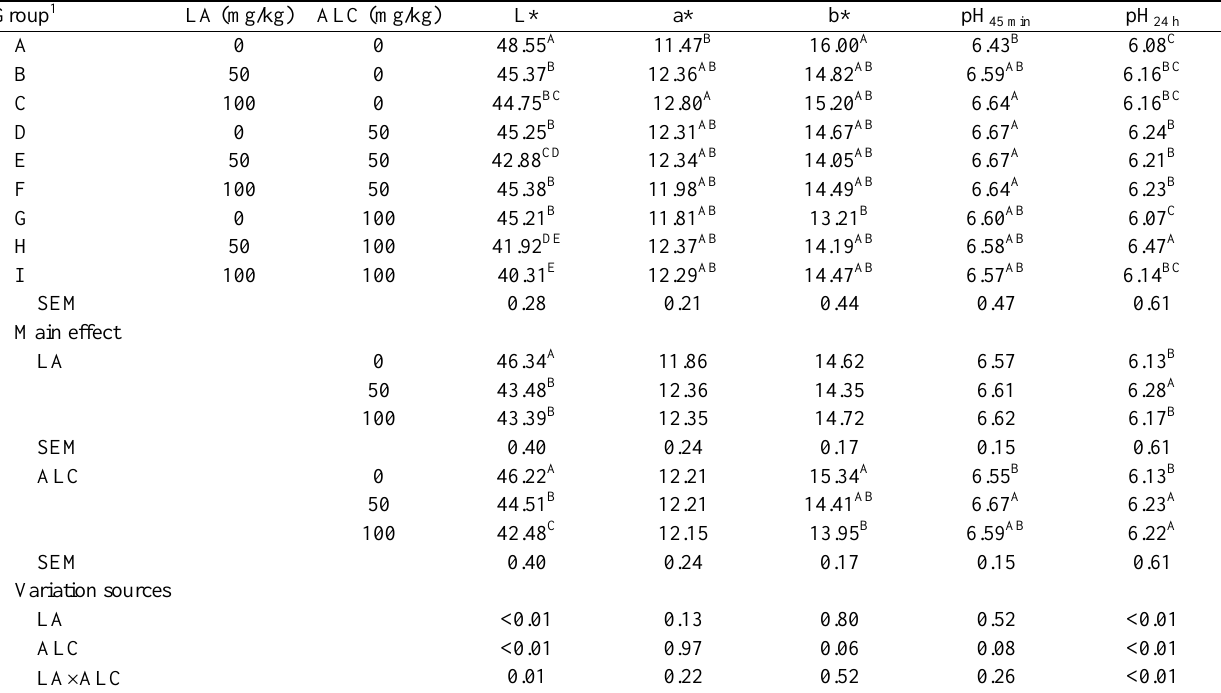
Table 5. Effects of dietary LA and ALC on the thigh muscle meat quality of broilers Group